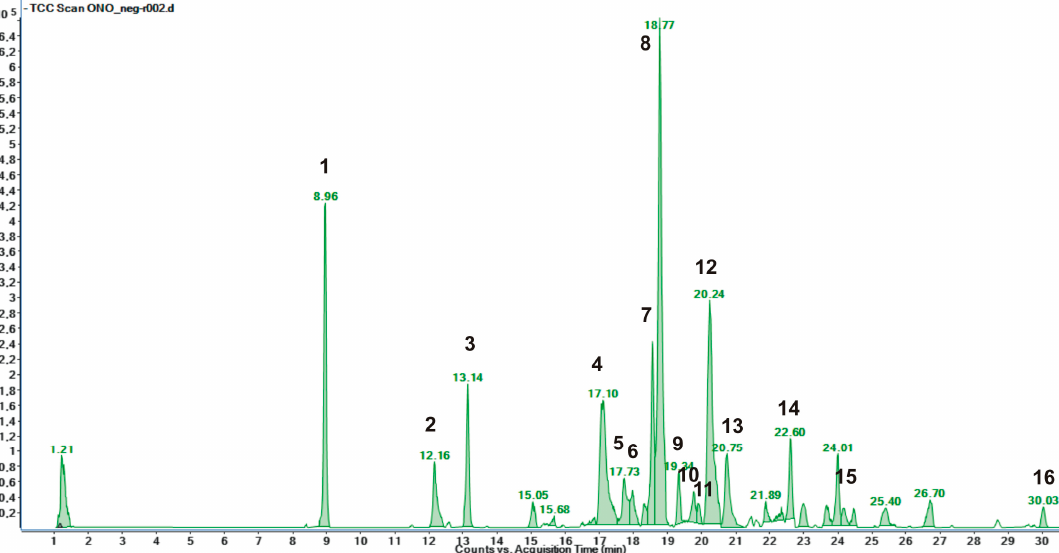
Figure 1. (HR) LC-ESI-QTOF MS/MS total compound chromatogram (TCC) of O. illyricum extract acquired in negative ion mode. Peak identification is given in Table 1.